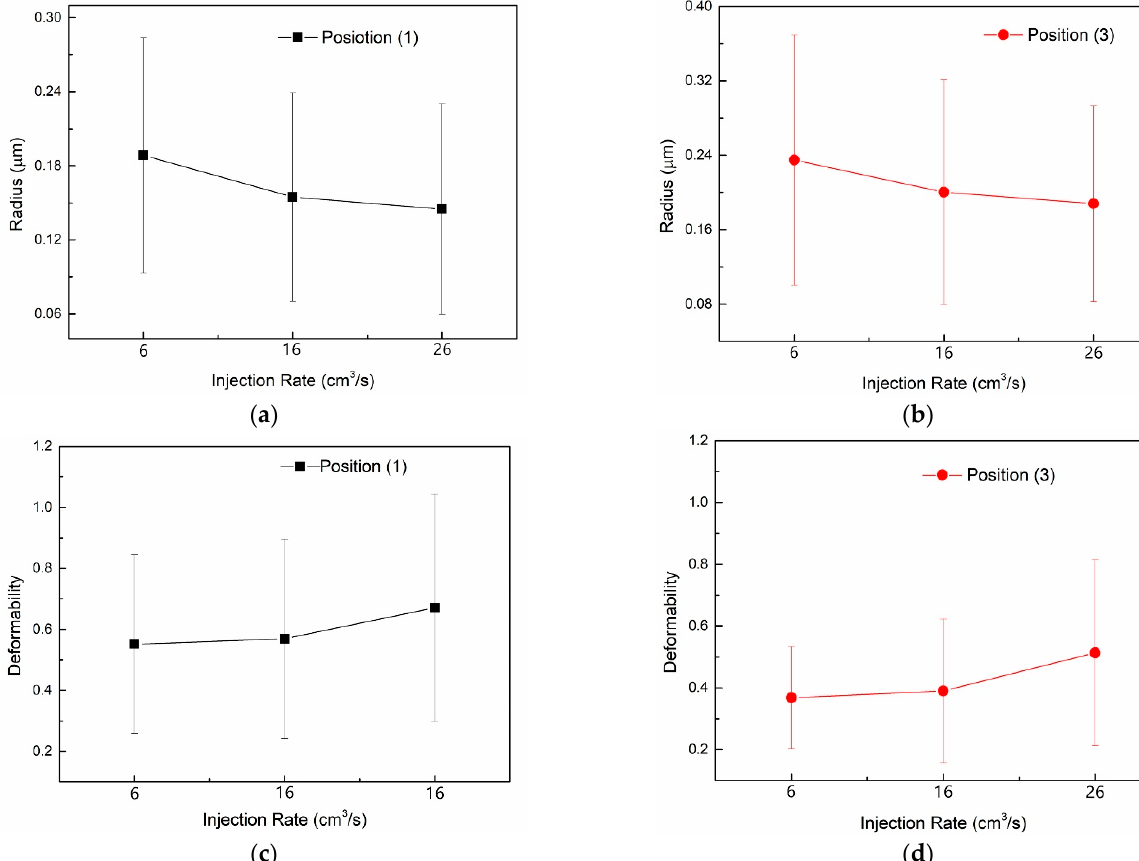
Figure 18. Statistics of droplets morphologies on the SEM images: equivalent radius of the droplets at Position 1 ( a ) and 3 ( b ); deformability of the droplets at Position 1 ( c ) and 3 ( d ).